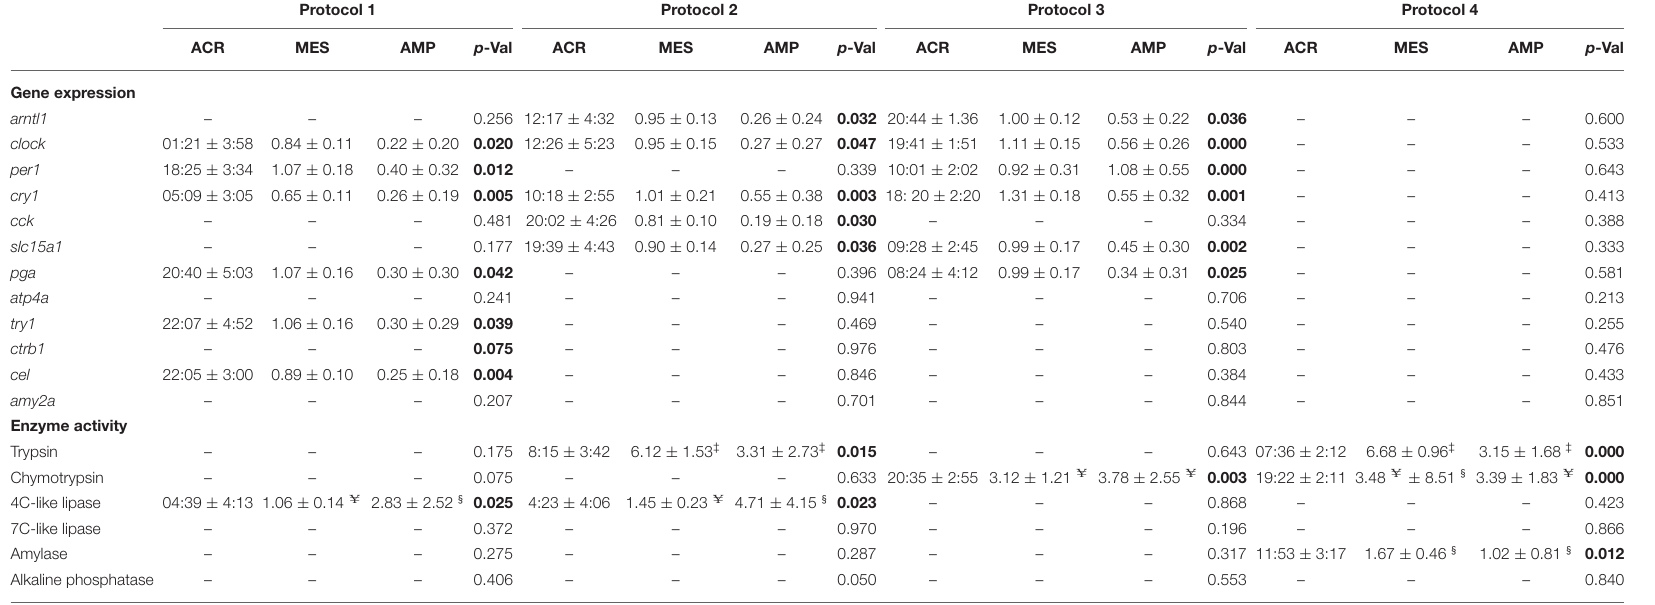
Values are as mean ± 95% confidence interval. Significance levels are highlighted in bold (p < 0.05). Acrophase values are expressed as ZT hours. For gene quantification and enzyme activity, Mesor and amplitude are displayed as “relative expression” and “RFU. g − 1 BM,” respectively. ( ‡ ) Values are in 10 7 units; ( U ) values are in 10 6 units; (§) values are in 10 5